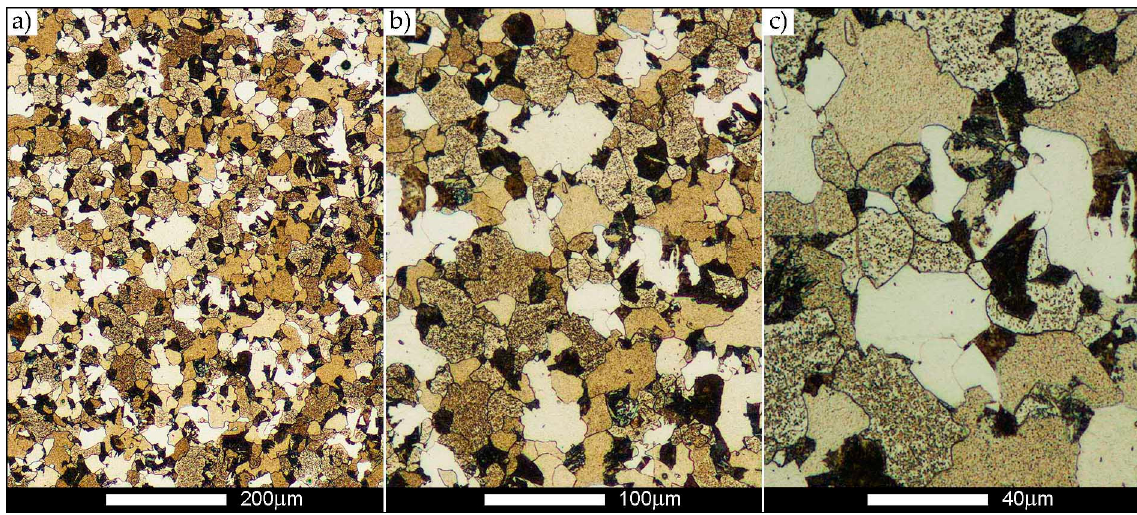
Figure 23. Welded joint microstructure of Hardox 450 steel in the normalised state with revealed grain boundaries of prior austenite—BM zone shown in Figure 2. ( a ) 100×; ( b ) 200×; ( c ) 500×.